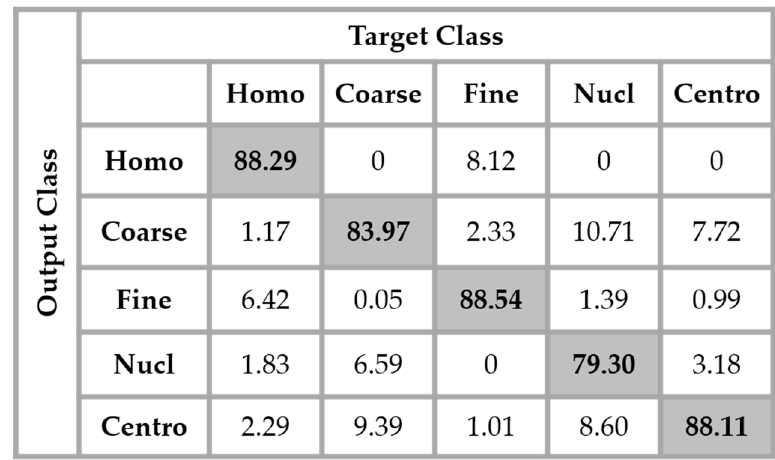
Figure 12. Confusion matrix of the results over the testing set by using the original cellular images as the inputs of one single network. The total accuracy of the network is 85.64%.